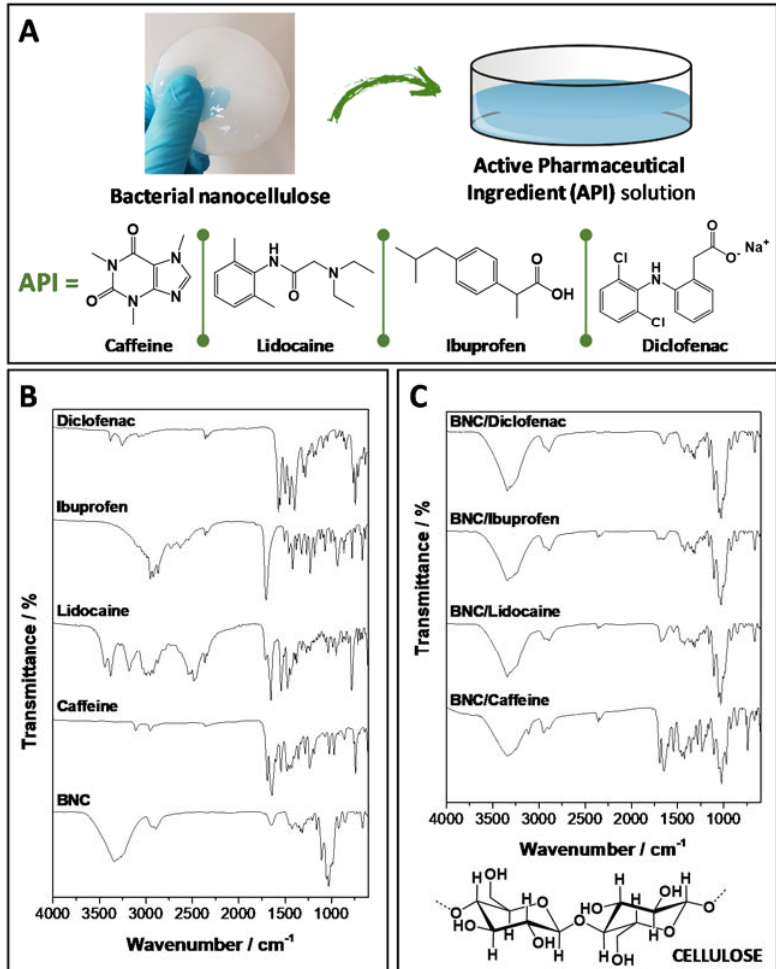
Figure 1. ( A ) Scheme showing the preparation of the active pharmaceutical ingredients (API)-loaded bacterial nanocellulose (BNC) membranes and the chemical structure of all drugs, ( B , C ) FTIR-ATR spectra of the individual components, namely, BNC, caffeine, lidocaine, ibuprofen and diclofenac ( B ), and of the four API ‐ loaded BNC membranes with the corresponding chemical structure of cellulose ( C ). Table 1. Identification of the API ‐ loaded BNC membranes with the respective drug dose.